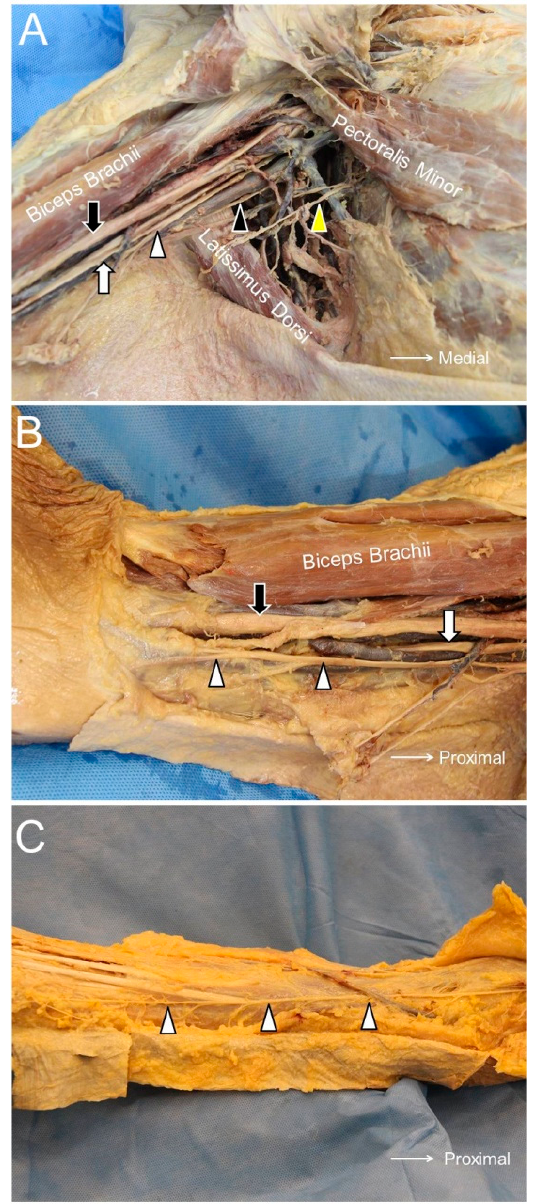
Figure 1. The medial brachial cutaneous nerve (black arrowhead), intercostal brachial cutaneous nerve (yellow arrowhead), and medial antebrachial cutaneous nerve (white arrowhead) in the axillary fossa (A) . The medial antebrachial cutaneous nerve at the level of the arm (B) and the forearm (C) . Black arrow, median nerve; white arrow, ulnar nerve.